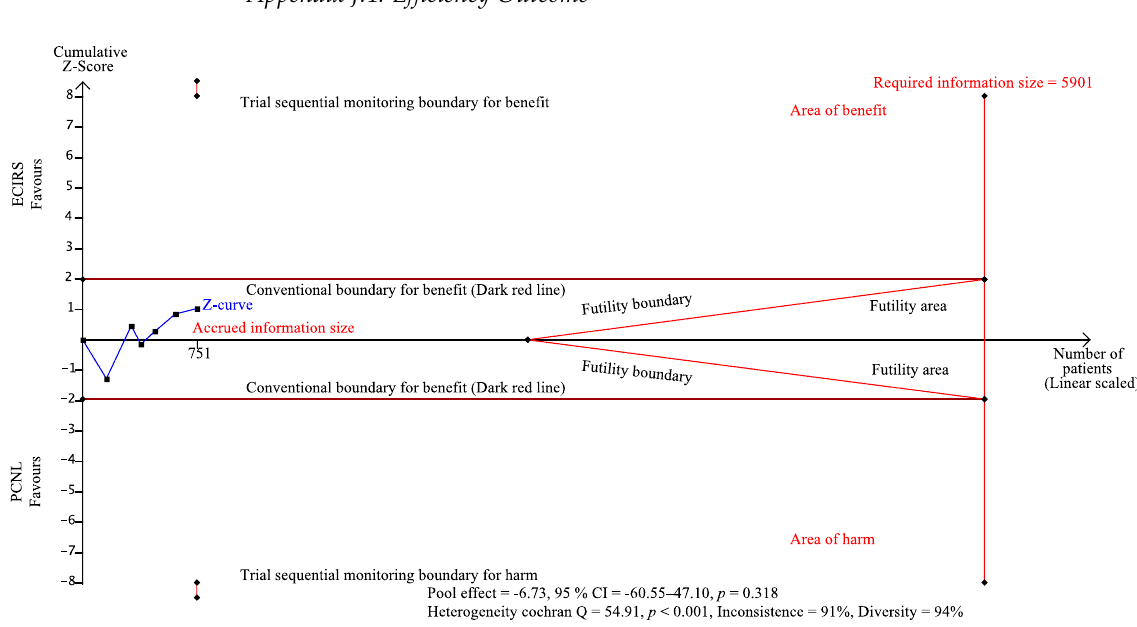
Figure A53. Comparison-adjusted funnel plot in outcome for operative time.